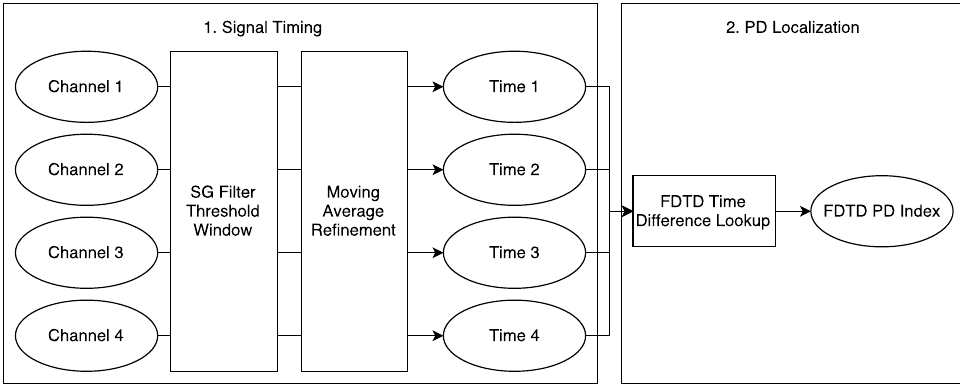
Figure 8. An overview of proposed PD localization